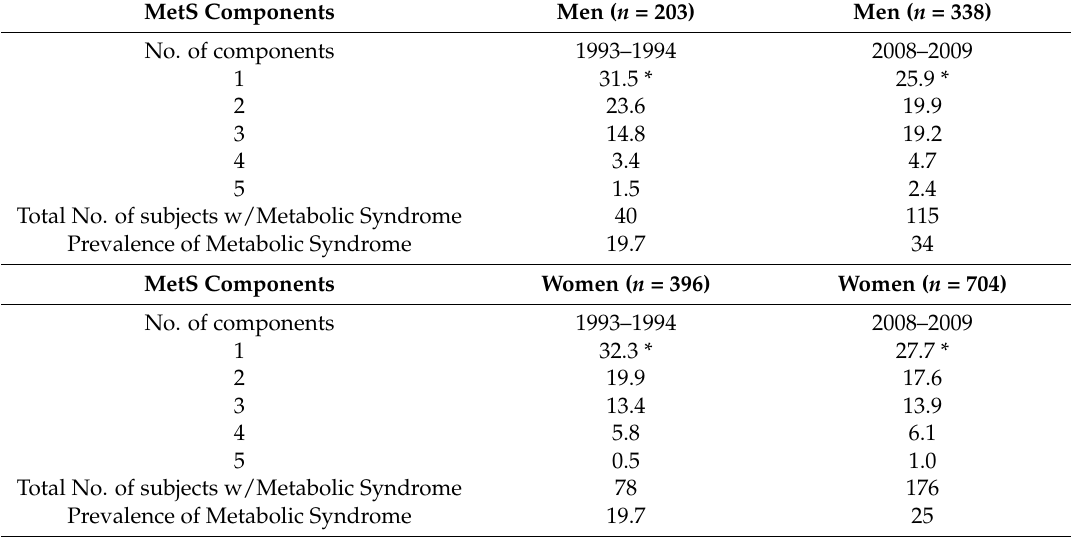
Table 3. Prevalence of metabolic syndrome clustering among Central and South American men and women from 1993–1994 and